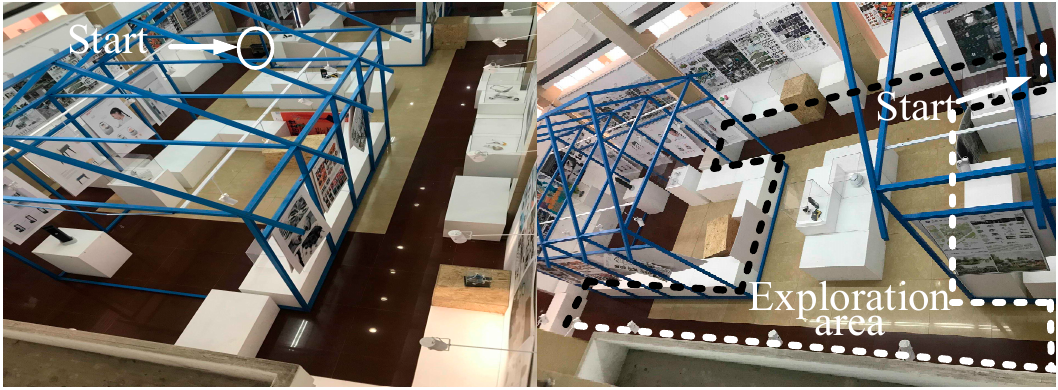
Figure 12. Experimental environment.